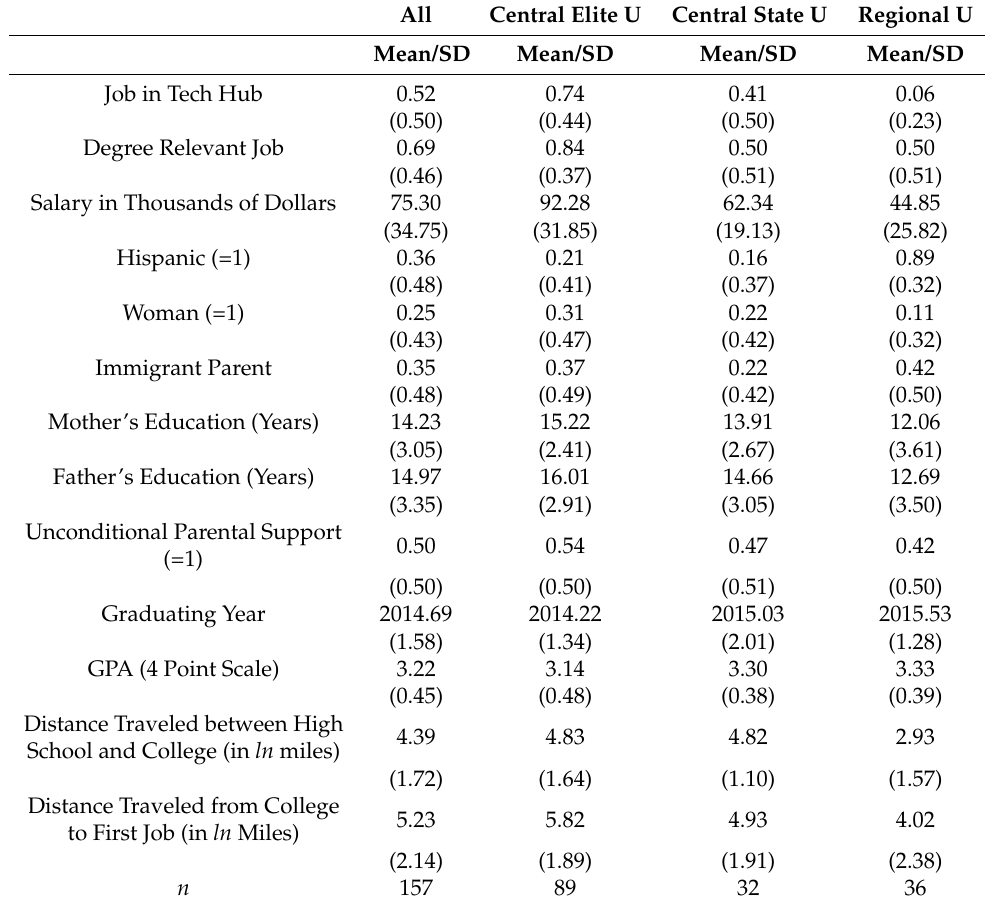
Table 2. Descriptive statistics for CS degree recipients from three Texas universities,